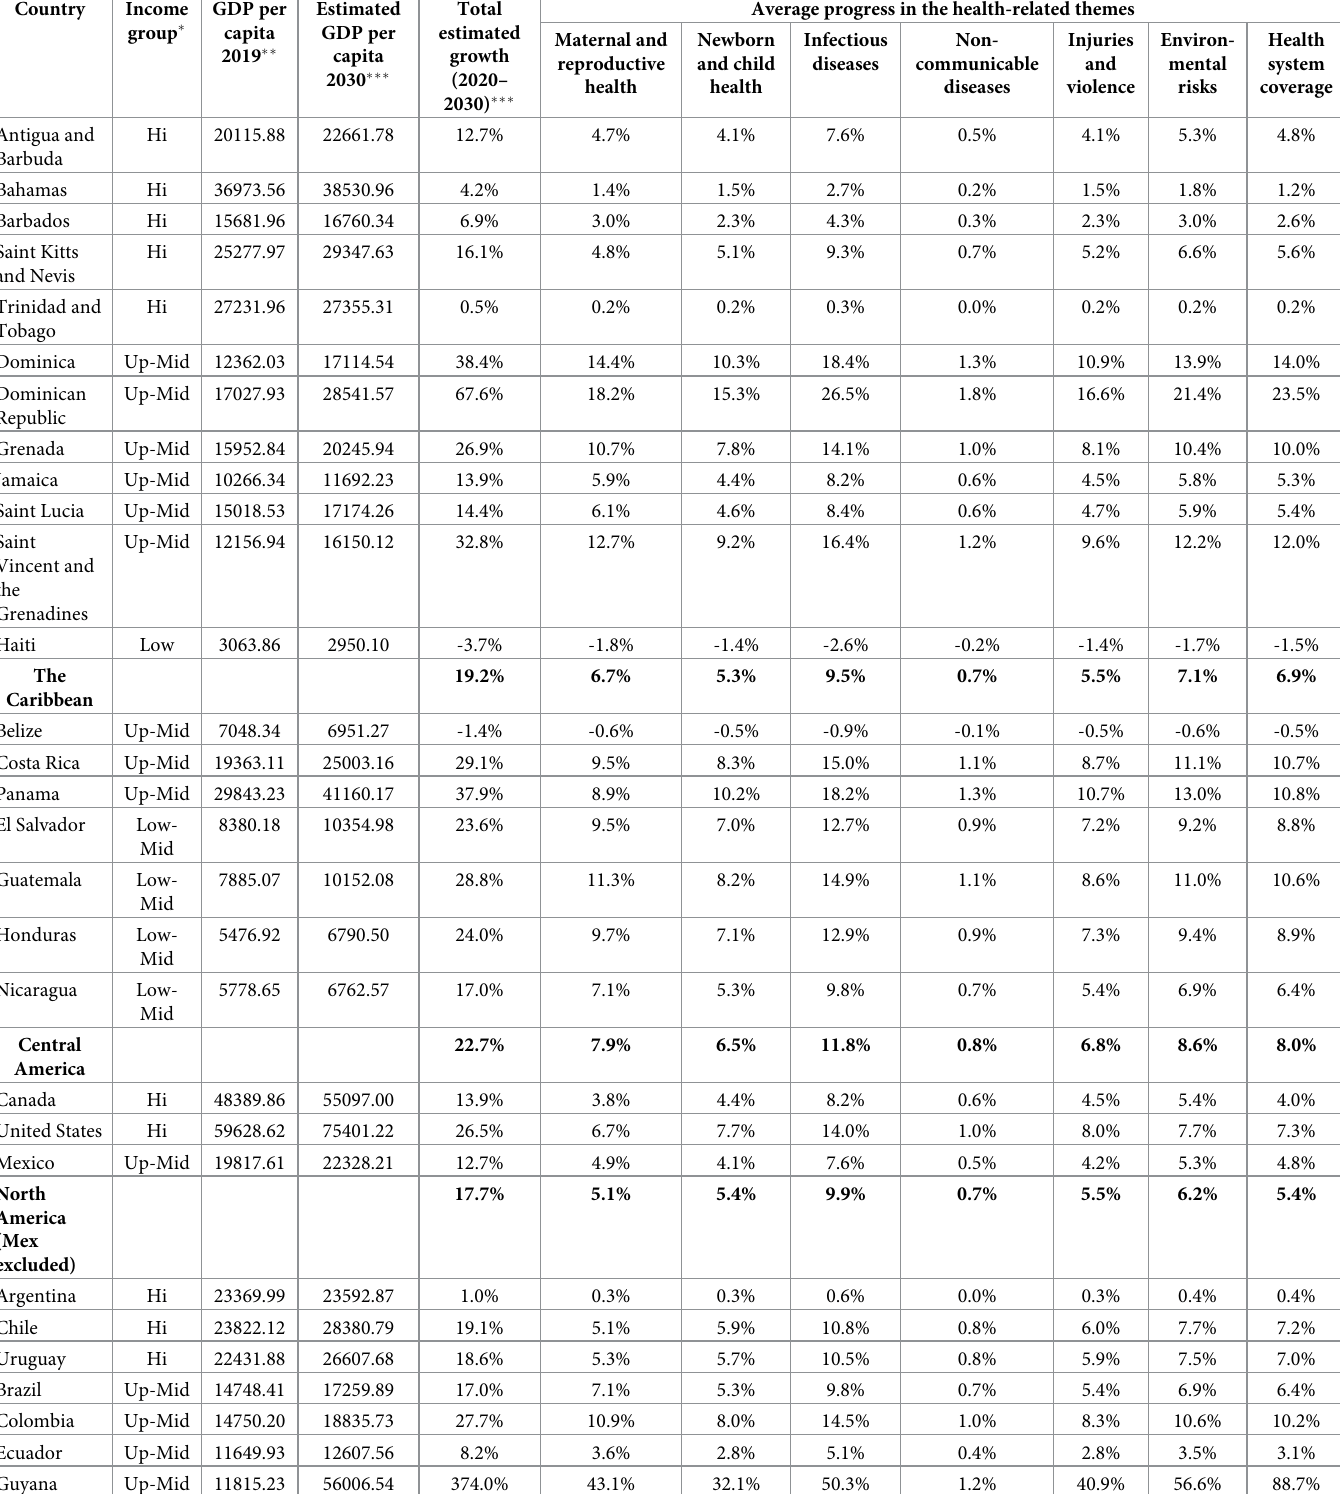
Table 3. Projected progress in the health-related themes until 2030: American countries. Country